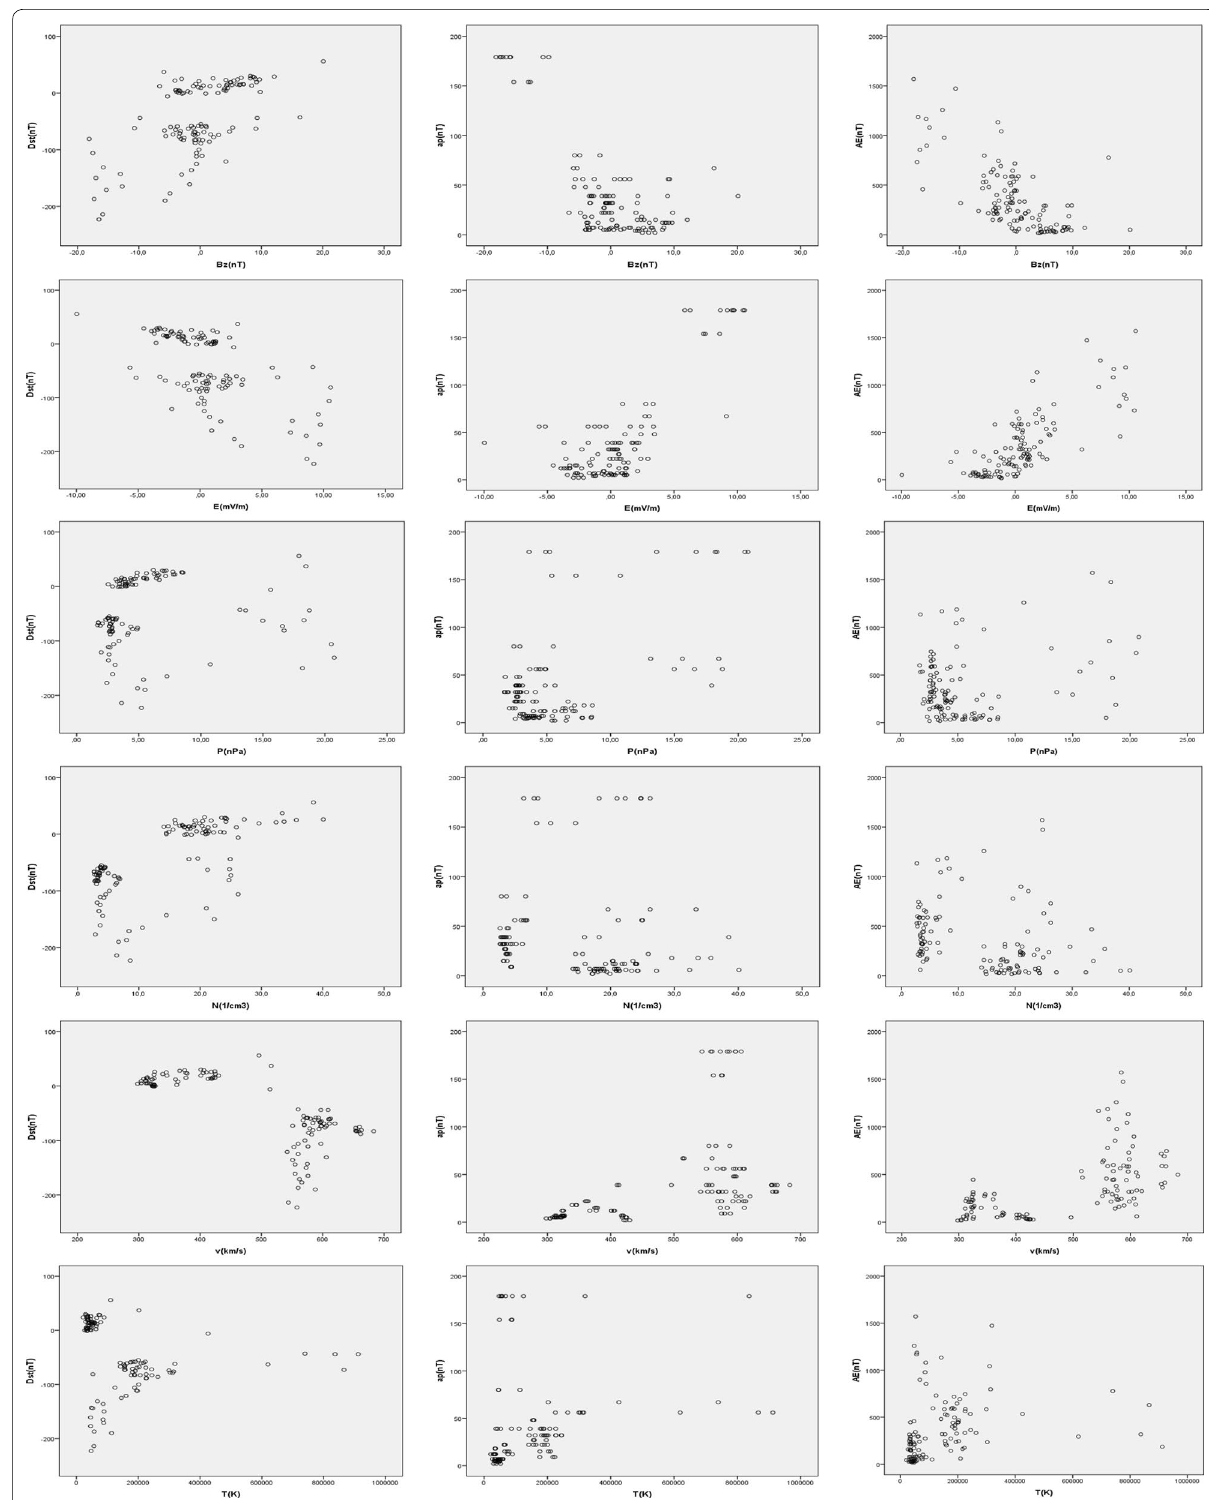
Fig. 2 Appearance between Dst, ap, AE indices and B z , E , P , N , v , T solar wind parameters. Relation between zonal geomagnetic indices (Dst, ap and AE) and solar wind parameters (magnetic field component ( B z ), the electric field ( E ), dynamic pressure ( P ), proton density ( N ), flow velocity ( v ), temperature ( T )) can be seen in Fig. 2. The relationships in the correlation are